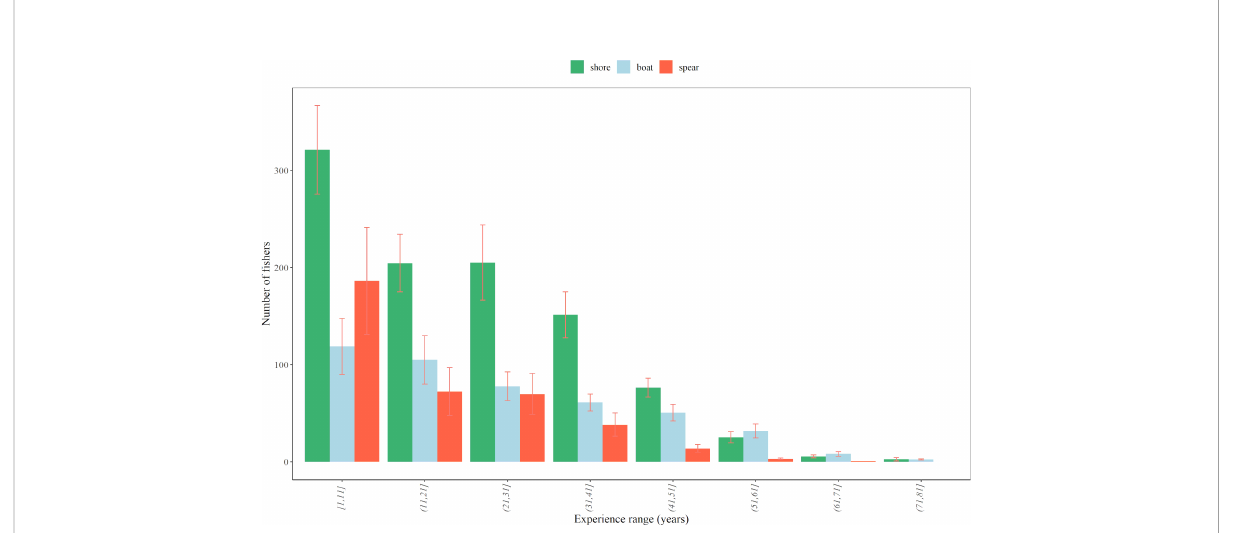
FIGURE 4 Number of fi shers per range of degree of experience (in years) for each fi shing mode, considering all sampling years and survey sources together (phone and email surveys, 2015-2019). Error bars denote the standard error.